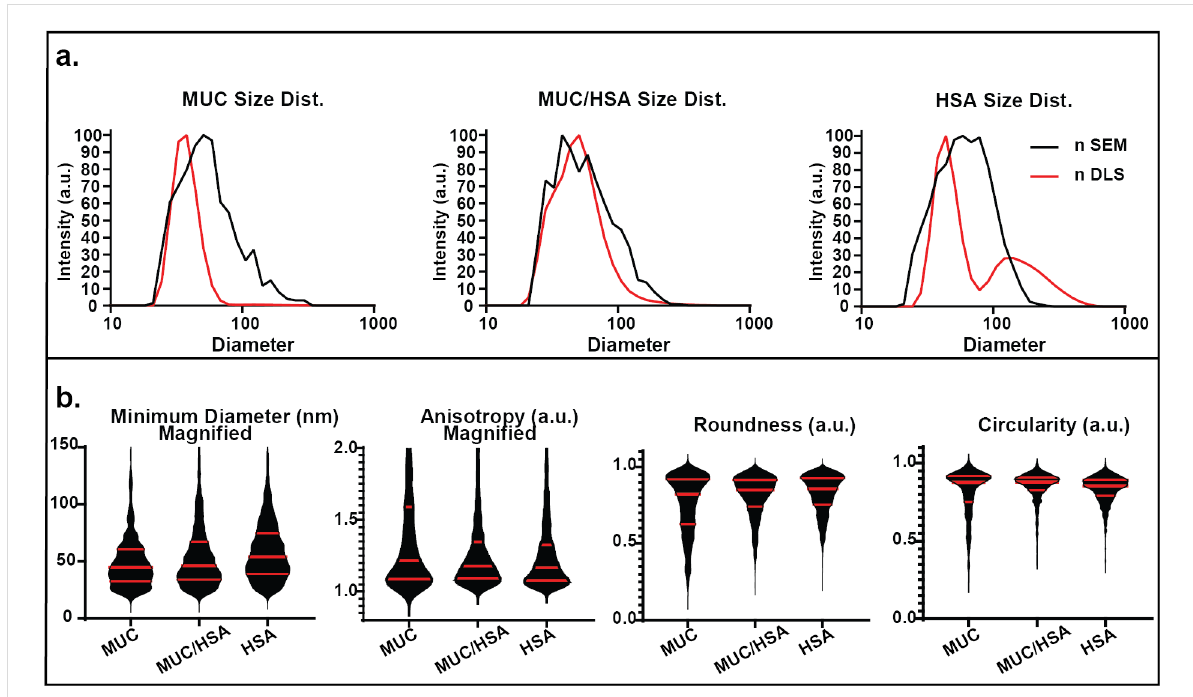
Figure 4: Size distribution and secondary geometric factors of MUC SPNPs based on SEM and DLS analysis. (a) Number distributions of SPNP sizes as obtained by SEM and DLS. (b) Violin graphs of minimum diameter, anisotropy, circularity and roundness (median and interquartile ranges are presented by red